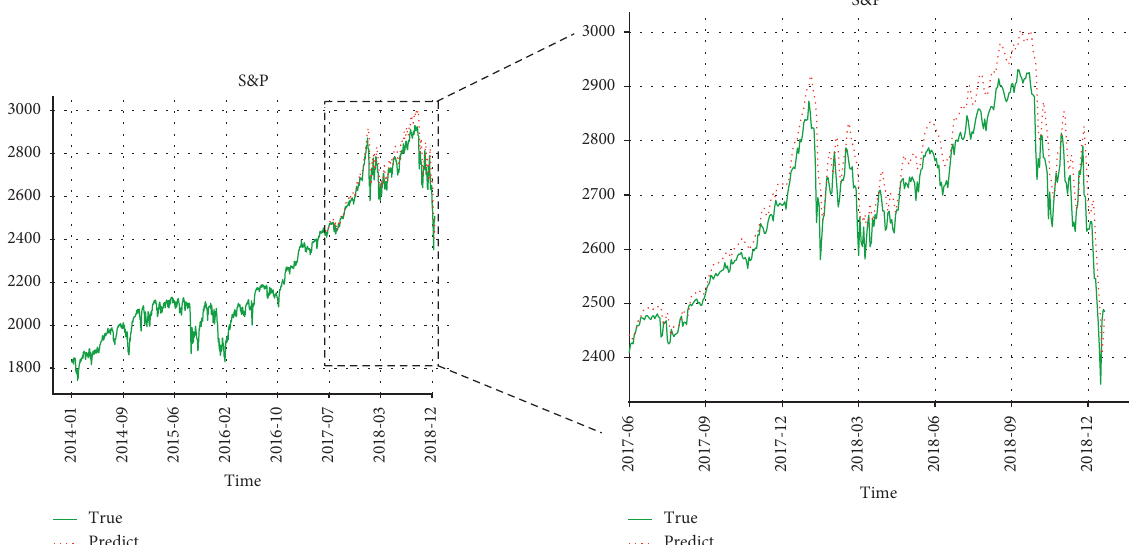
Figure 4: The S&P index prediction without consideration of the bitcoin